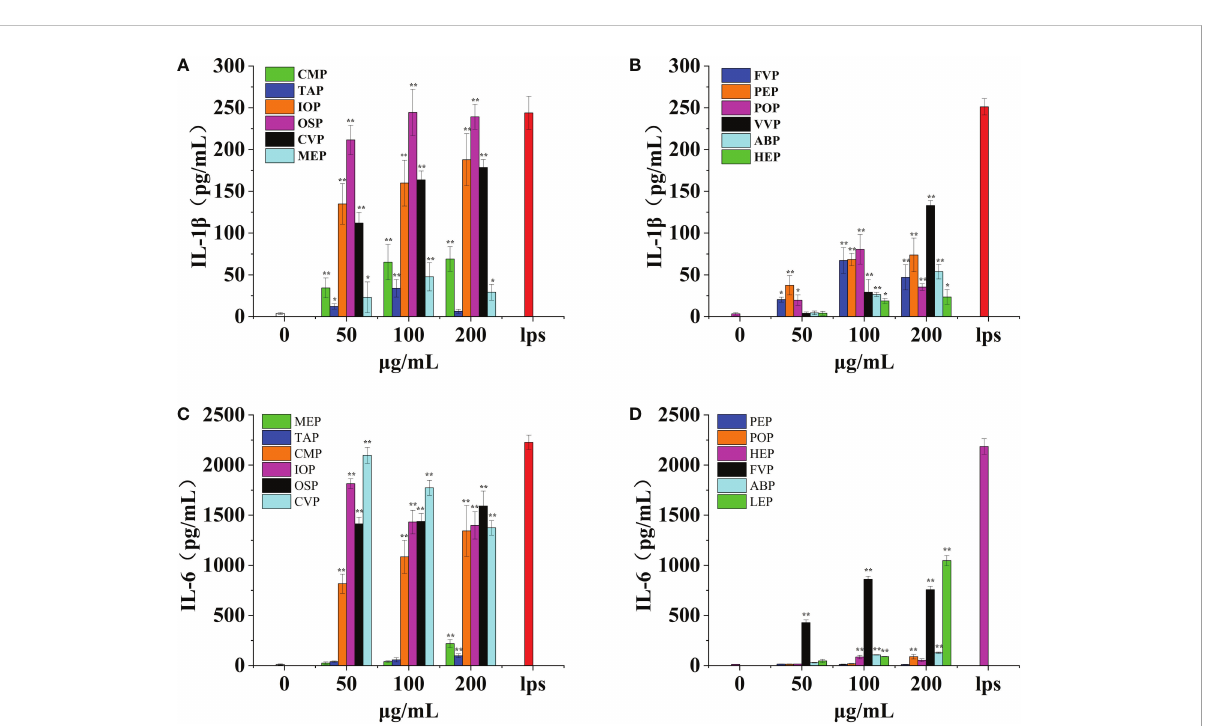
FIGURE 9 Effect of six rare edible mushrooms on IL-1ß production in RAW 264.7 macrophages (A) . Effect of six common edible bacteria on IL- 1ß production in RAW 264.7 macrophages (B) , Effect of six rare edible bacteria on IL-6 production in RAW 264.7 macrophages (C) , Effect of six common edible bacteria on IL-6 production in RAW 264.7 macrophages (D) . *p < 0.05, **p < 0.01 indicates statistically signi fi cant difference compared to positive control